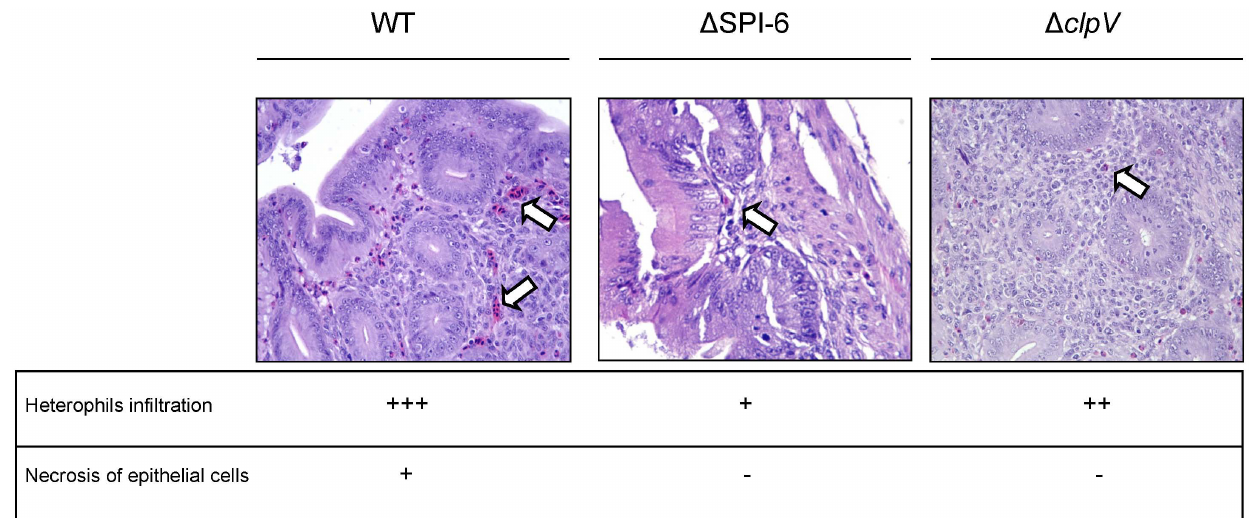
Figure 3. Histopathological changes in the cecum of infected chicks at day 3 post-infection. Groups of 3 White Leghorn chicks were inoculated intragastrically by gavage with 10 9 CFU of the wild type S . Typhimurium 14028 s strain, the D T6SS SPI-6 mutant strain or the D clpV mutant strain. At day 3 post-infection the chicks were sacrificed and the ceca were excised, fixed, stained with hematoxylin and eosin, and analyzed for histopathological lesions. Representative images of stained sections (400X) and scores for histopathological lesions in the cecum of infected chicks are shown (-, no changes; + , mild; ++ , strong; +++ , severe). White arrows indicate heterophil infiltration.